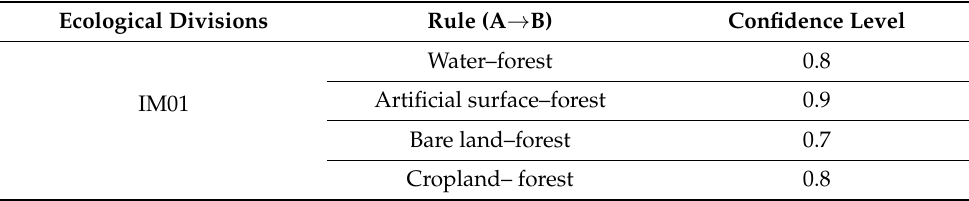
Table 7. Rules with confidence levels over 0.7 for large IM01 ecological divisions.